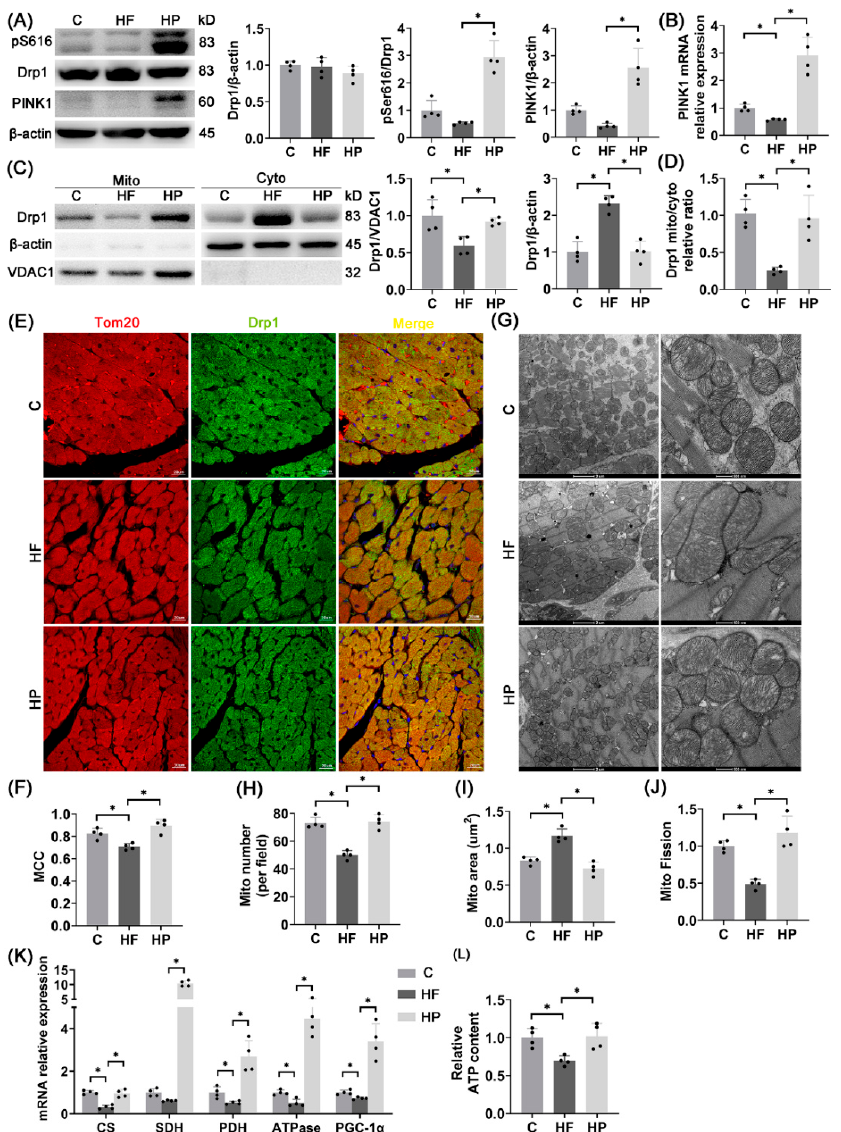
Figure 7. PINK1 overexpression stimulates pDrp1 S616 -mediated fission to improve mitochondrial function. ( A ) Drp1 total protein expression, Drp1 S616 phosphorylation level, and PINK1 protein expression in the LV; n = 4 per group. ( B ) PINK1 mRNA expression in the LV; n = 4 per group. ( C , D ) Drp1 protein level on mitochondria, Drp1 protein level in cytoplasm ( C ) and the relative ratio of mitochondrial Drp1 to cytoplasmic Drp1 ( D ) after the separation of LV mitochondria and cytoplasmic proteins; n = 4 per set. ( E , F ) Representative images of immunofluorescence of the LV (red: mitochondrial outer membrane marker, Tom20, green: Drp1, blue: DAPI, Scale bar: 20 µ m) ( E ) and Manders co-localization coefficient (MCC) quantitative analysis of Tom20 and Drp1 (5 fields analyzed per sample, 4 samples per group) ( F ). ( G – J ) Representative images of mitochondrial transmission electron microscopy in the LV (Scale bar: 2 µ m, 500 nm) ( G ) and quantitative analysis of the number of mitochondria per unit field of view (analysis of >100 mitochondria per sample, 4 samples per group) ( H ), quantitative analysis of mitochondrial area (more than 100 mitochondria analyzed per sample, 4 samples per group) ( I ), and quantitative analysis of mitochondrial fission index (ratio of mitochondrial number to mitochondrial area, n = 4 per group) ( J ). ( K ) mRNA expression of mitochondrial function-related genes CS, SDH, PDH, ATPase and PGC-1 α in the LV; n = 4 per group. ( L ) Relative ATP levels in rat hearts (normalized using protein concentration); n = 4 per group. The data are mean ± SD, * p < 0.05 compared to the other